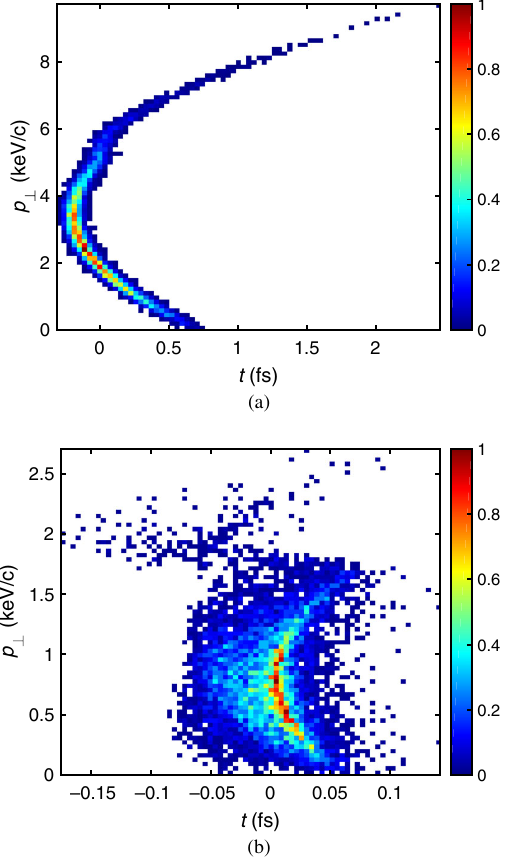
FIG. 4. Correlation between time and transverse momentum at the sample location. Examples are shown for both (a) typical and (b) minimal bunch